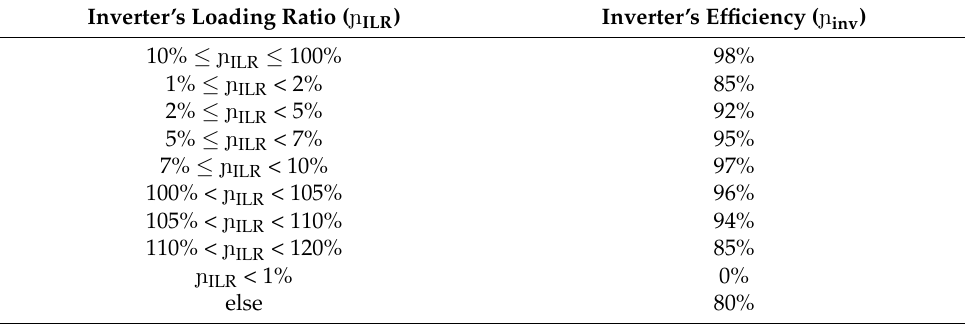
Table 1. The estimated inverter